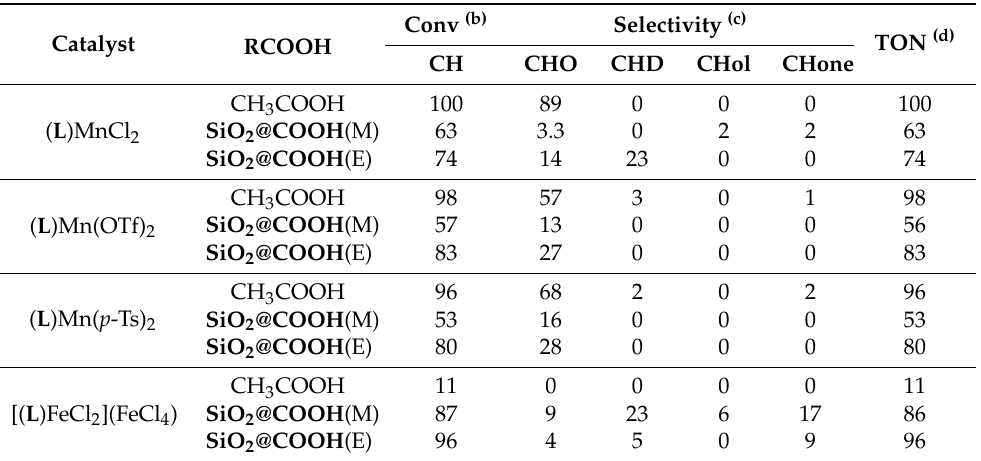
Table 5. Relevant data for the catalyzed (ep)oxidation of cyclohexene (a) . Catalyst